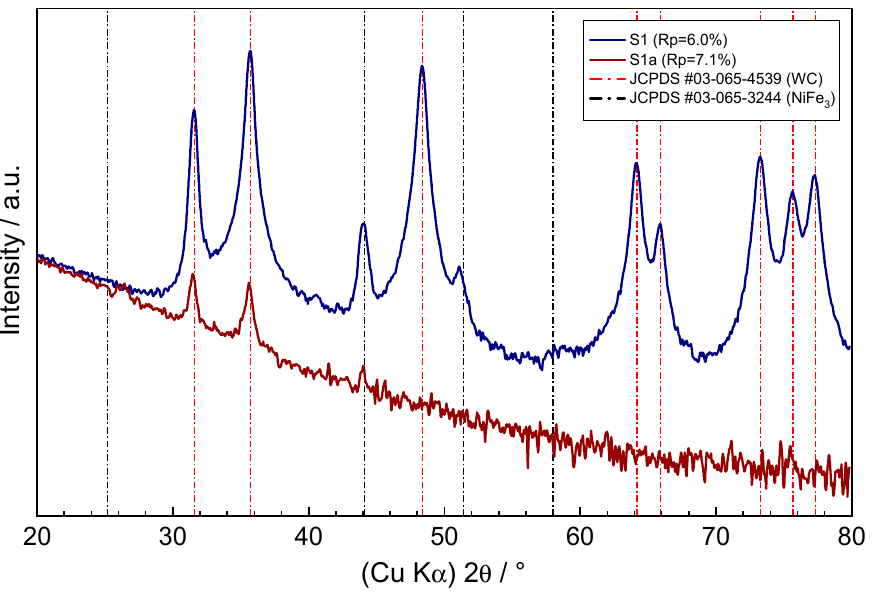
Figure 4. Grazing incidence XRD pattern of the WC–9FeNi–1Cr 3 C 2 –0.5NbC sample before (S1) and after the corrosion process (S1a).